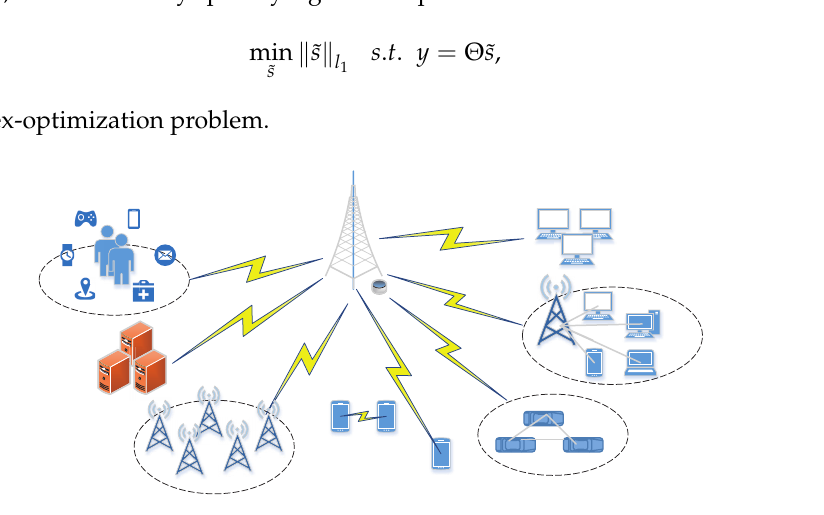
Figure 1. Network architecture is increasingly complex, and transmitted network data increasingly